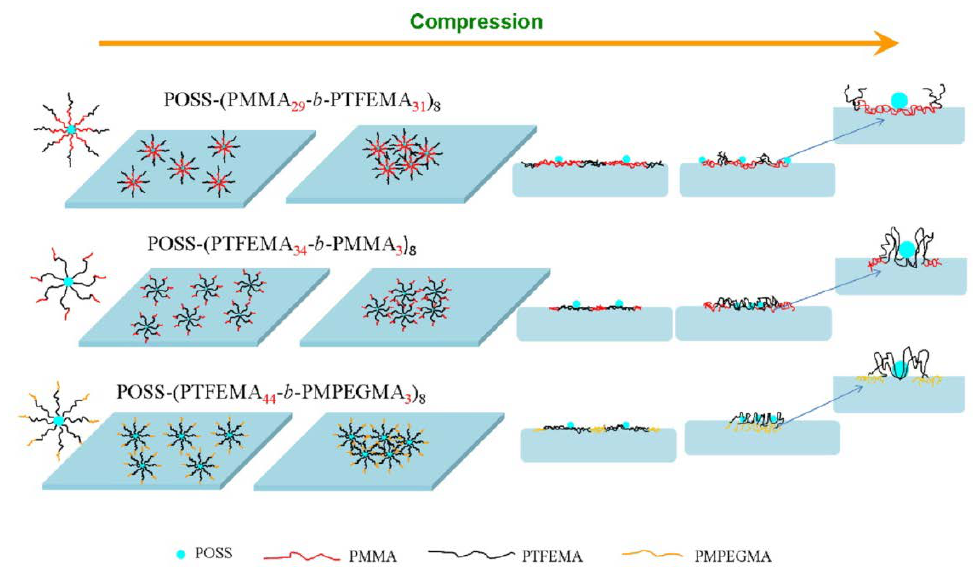
Figure 11. Proposed packing model of the three-copolymer self-assembly at the air–water interface. Reprinted with permission from [116]. Copyright (2016) Springer Nature.